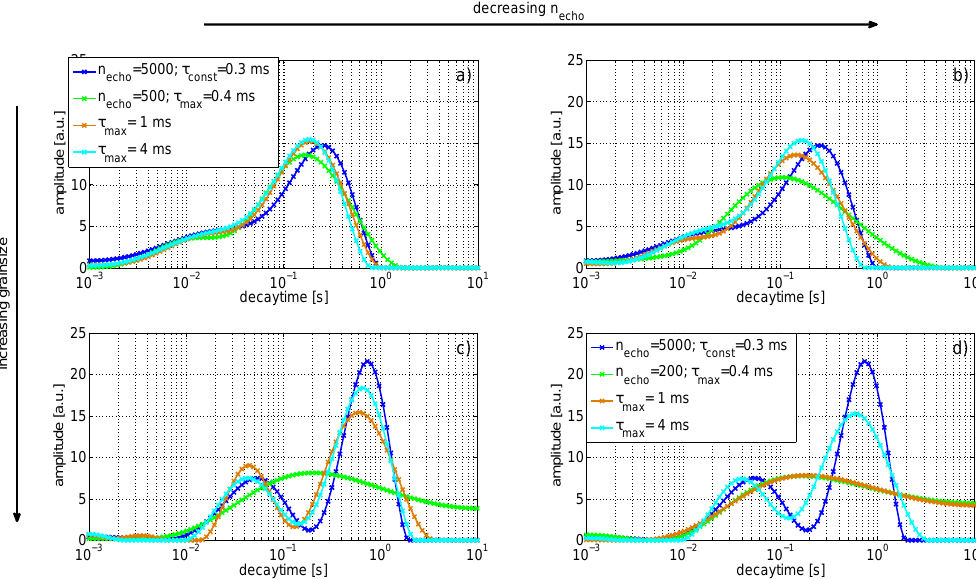
Fig. 8. T 2 distribution of granular material for pulse sequences with a linearly increased τ . n echo is decreasing from left to right beginning ( n echo =500–200). The grain size increases from top (medium sand) to bottom (coarse